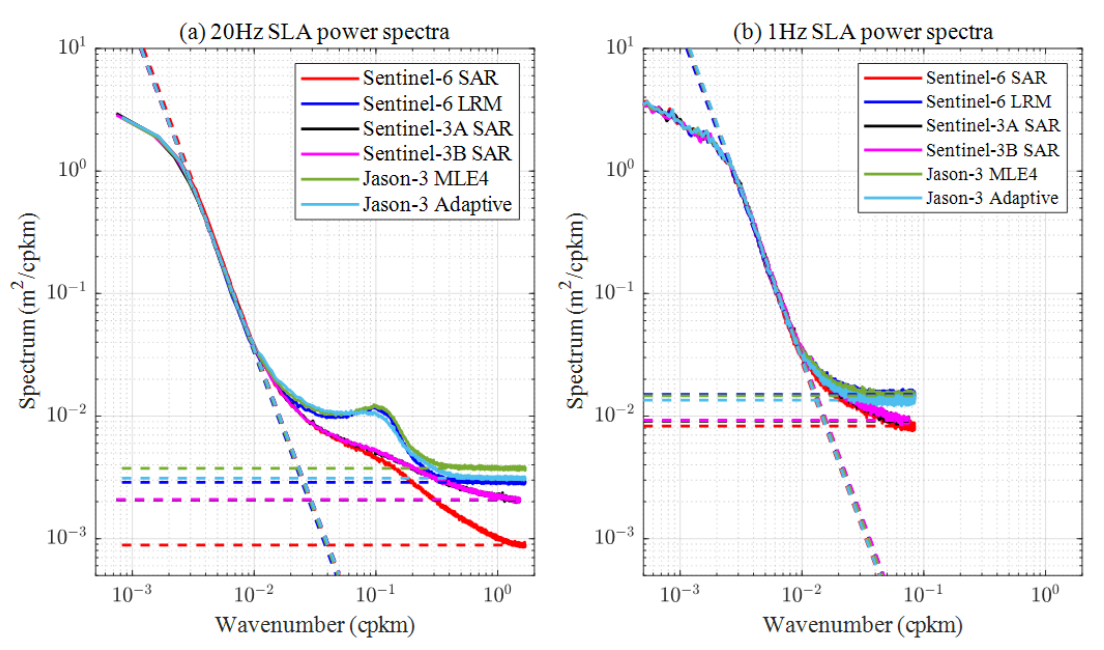
Figure 3. Sea level anomaly spectra of Sentinel-6 ( a ) 20-Hz SLA and ( b ) 1 Hz SLA and their compar- isons with Jason-3 and Sentinel-3A/B